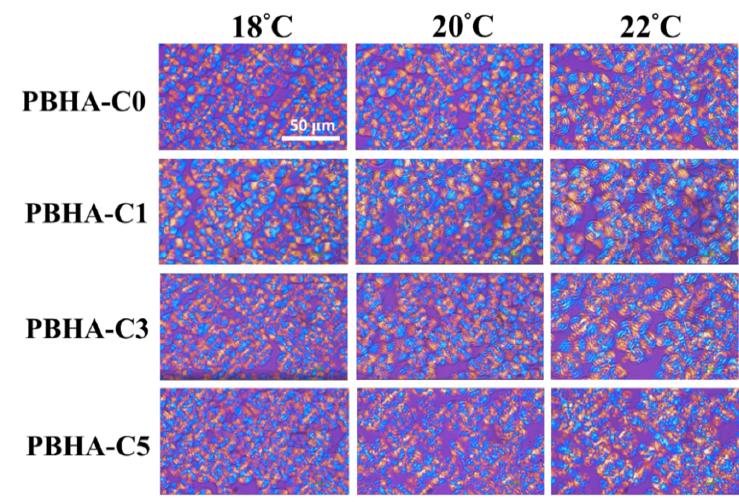
Figure 7. POM images of PBHA-Cn copolymers at a given temperature.